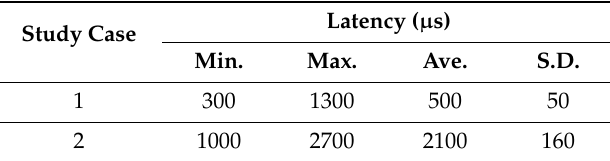
Table 1. Results from Case 1 and Case